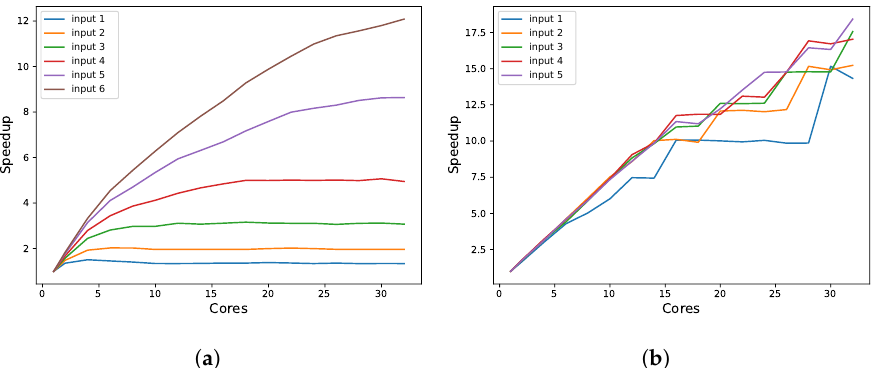
Figure 6. Speedup of the applications for several input sizes. ( a ) Raytrace speedup. ( b ) OpenMC speedup.